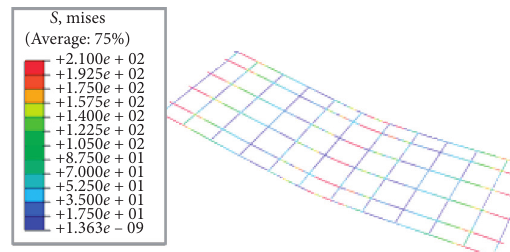
Figure 31: Cloud chart of the stress on the rebar net under ultimate load.